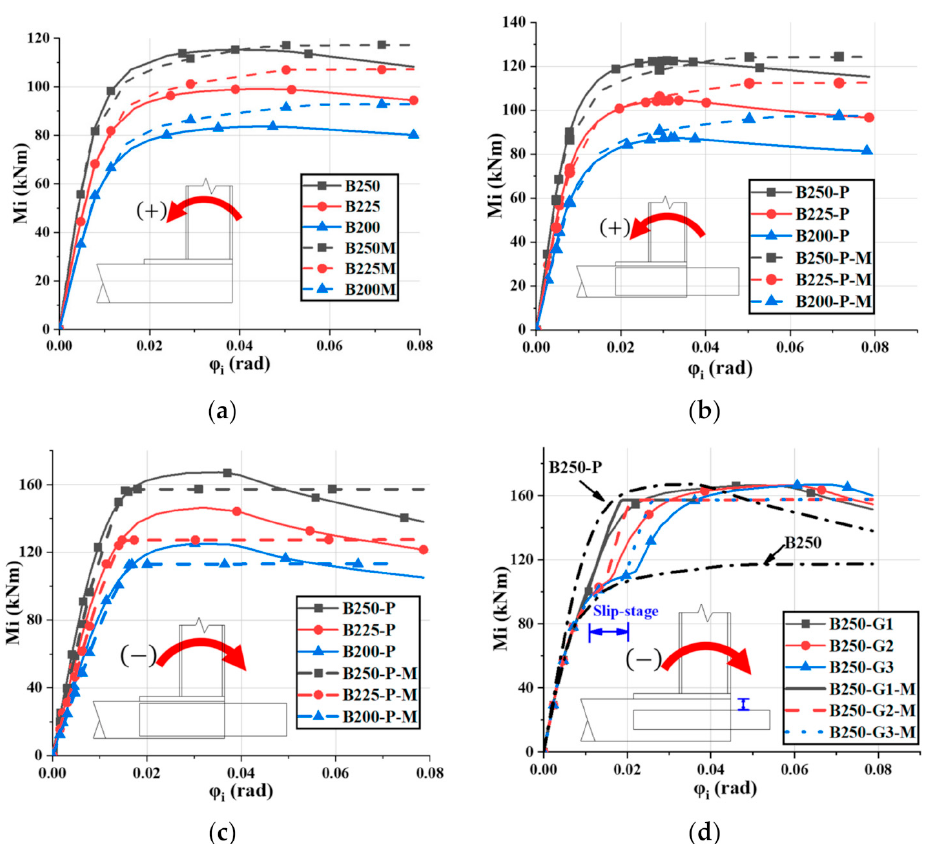
Figure 42. Moment-rotation curves of intramodule connections: ( a ) Under positive bending moment without inbuild component; ( b ) Under positive bending moment with inbuild component; ( c ) Under negative bending moment with inbuild component; ( d ) Under negative bending moment with inbuild component and take construction errors into consideration. Table 3. The comparison between simplified and finite element model. Joint